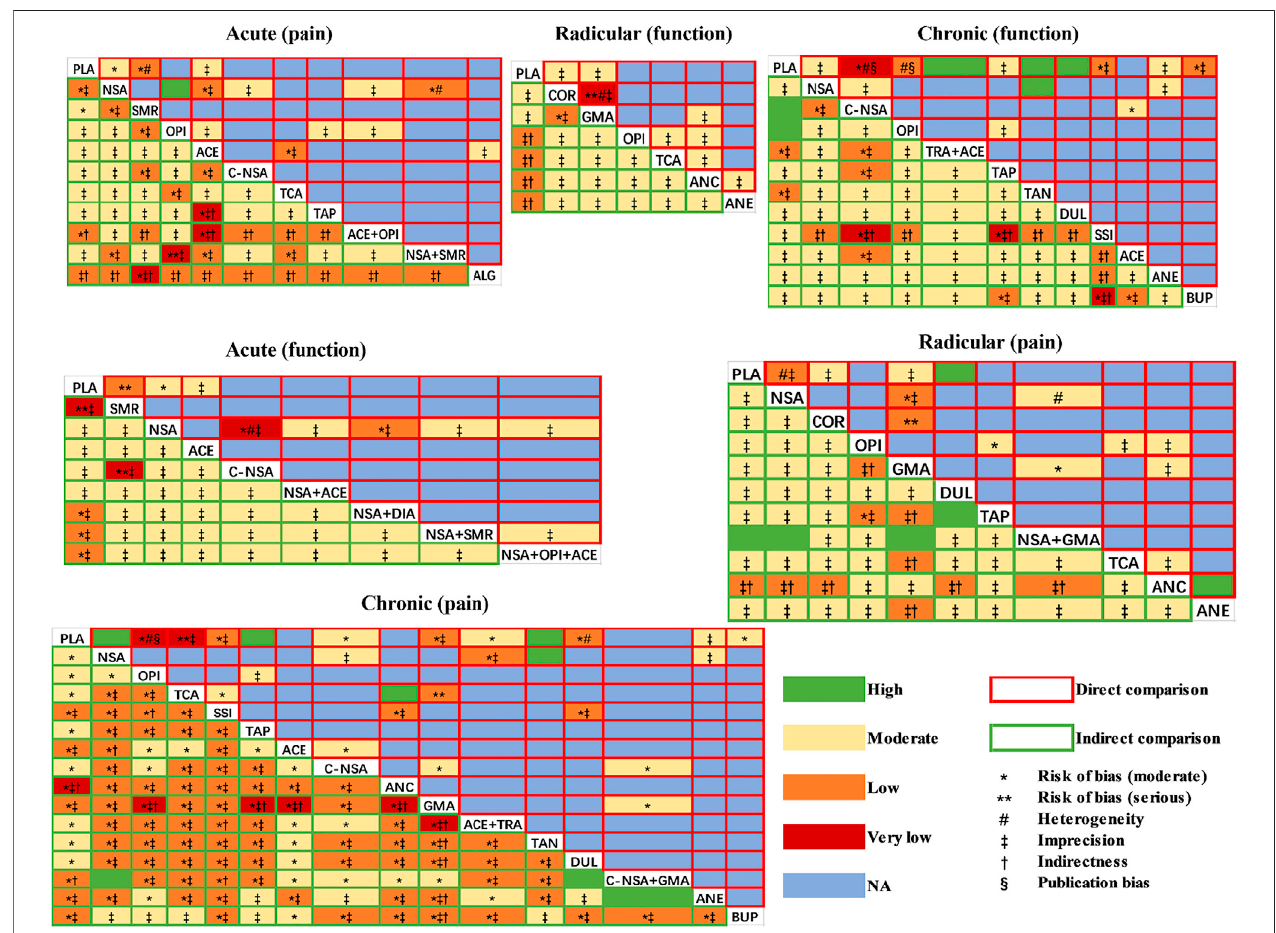
FIGURE 6 | The quality of the estimates of direct and indirect evidence (GRADE